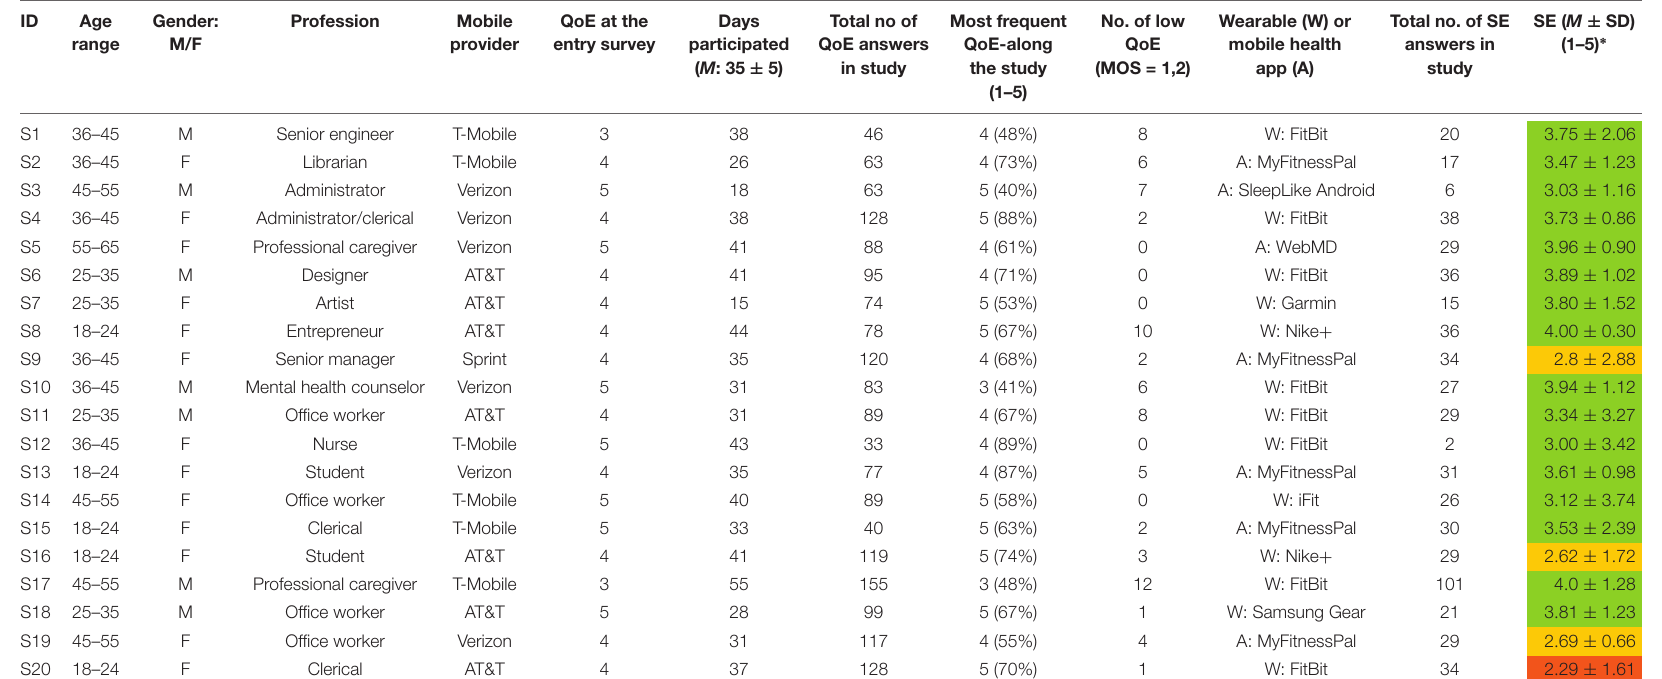
TABLE 1 | Characteristics of the 20 participants collecting data for at least 4